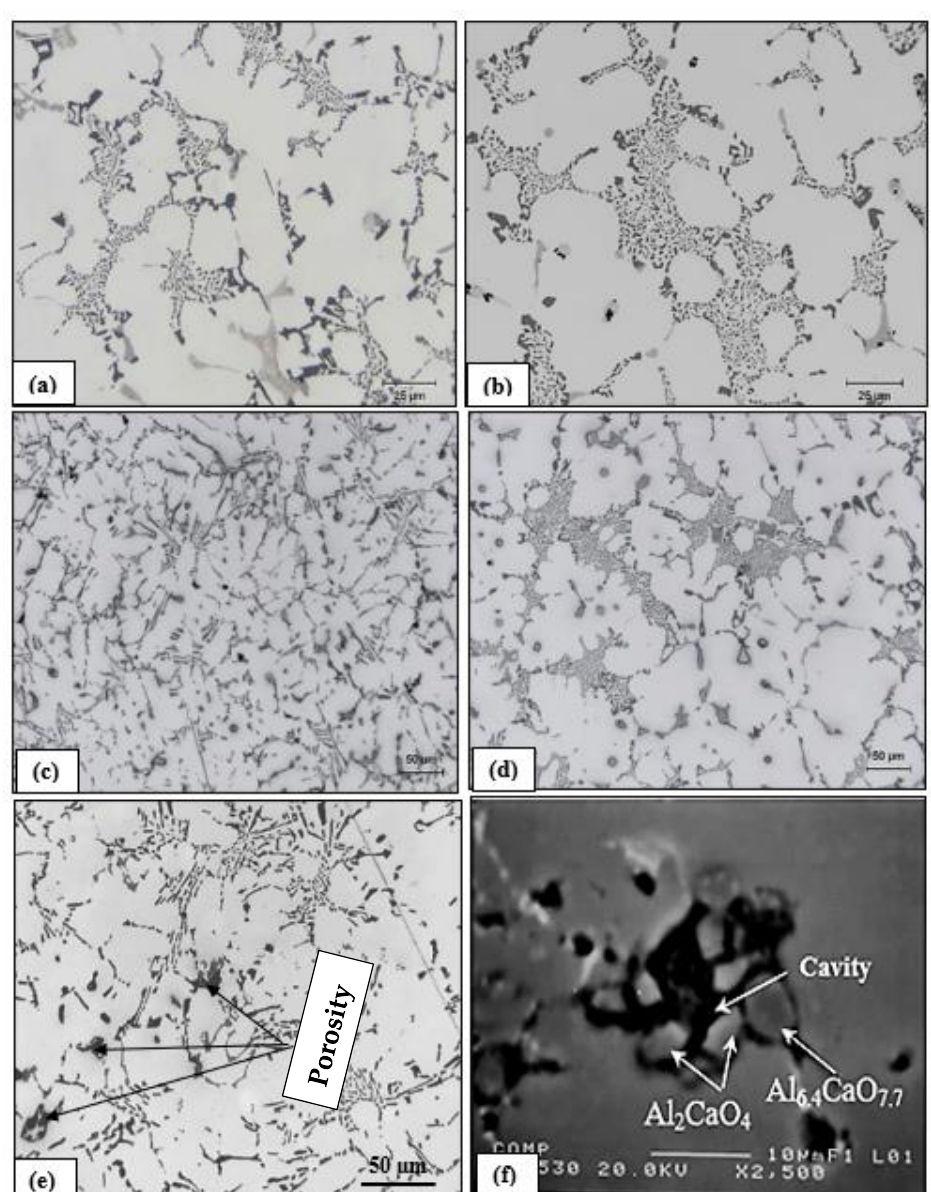
Figure 6. ( a , c , e ) B, BB2 and BB6 alloys, respectively, ( b , d , f ) C, CC and CC5 alloys, respectively (medium mold, mold angle 5 ◦ ). Note the de-modification effect of Bi, compared to that of Ca. In all cases, thermocouples were placed ~ 6.5 cm from the bottom, away from the shrinkage cavity). Gray compounds in ( f ) are mostly Al-Ca-O oxides.